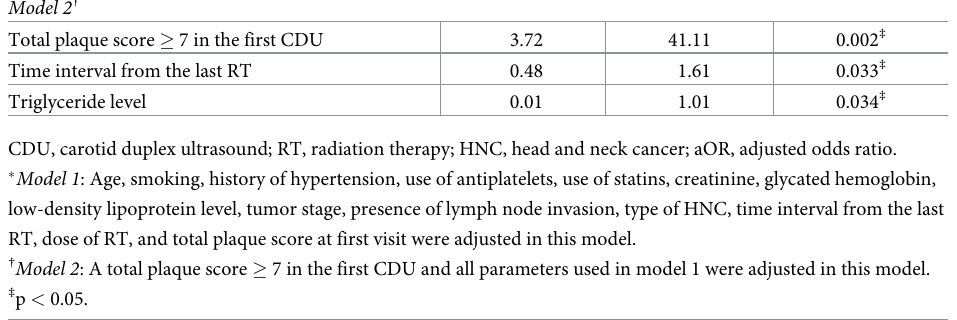
Table 1. Multivariate logistic regression analysis of the predictors of carotid stenosis progression within the first 2 years. β aOR p Model 1 � Total plaque score at the first CDU 0.53 1.69 0.002 ‡ Time interval from the last RT 0.46 1.58 0.027 ‡ Age -0.15 0.86 0.041 ‡ Triglyceride level 0.01 1.01 0.065 Model 2 † Total plaque score � 7 in the first CDU 3.72 41.11 0.002 ‡ Time interval from the last RT 0.48 1.61 0.033 ‡ Triglyceride level 0.01 1.01 0.034 ‡ CDU, carotid duplex ultrasound; RT, radiation therapy; HNC, head and neck cancer; aOR, adjusted odds ratio. � Model 1 : Age, smoking, history of hypertension, use of antiplatelets, use of statins, creatinine, glycated hemoglobin, low-density lipoprotein level, tumor stage, presence of lymph node invasion, type of HNC, time interval from the last RT, dose of RT, and total plaque score at first visit were adjusted in this model. † Model 2 : A total plaque score � 7 in the first CDU and all parameters used in model 1 were adjusted in this model. ‡ p <